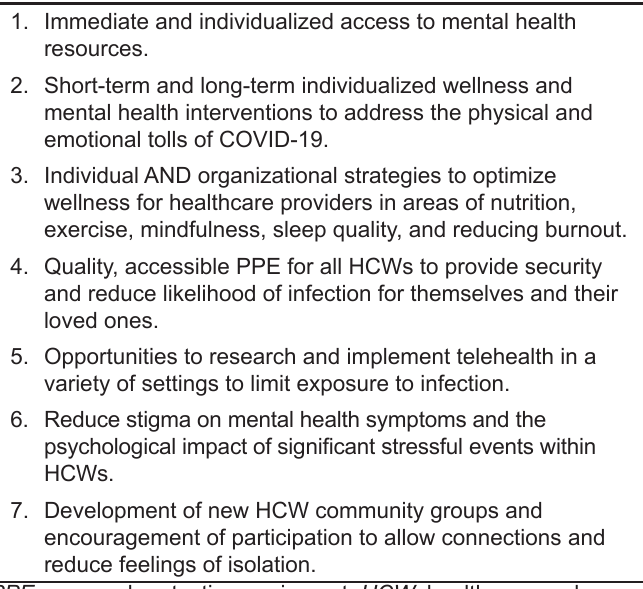
PPE , personal protective equipment; HCW , healthcare